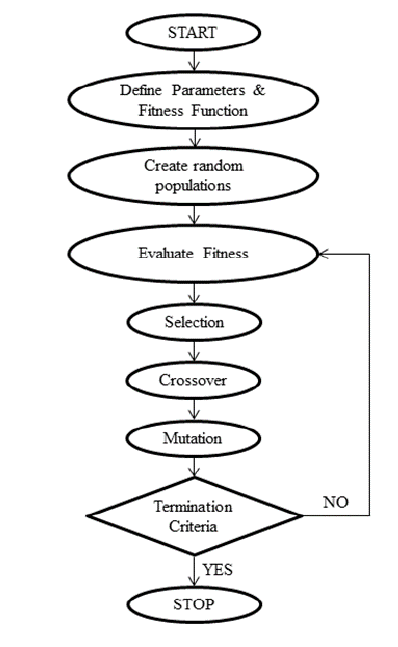
Figure 3. The flowchart of the process cycle for the GA